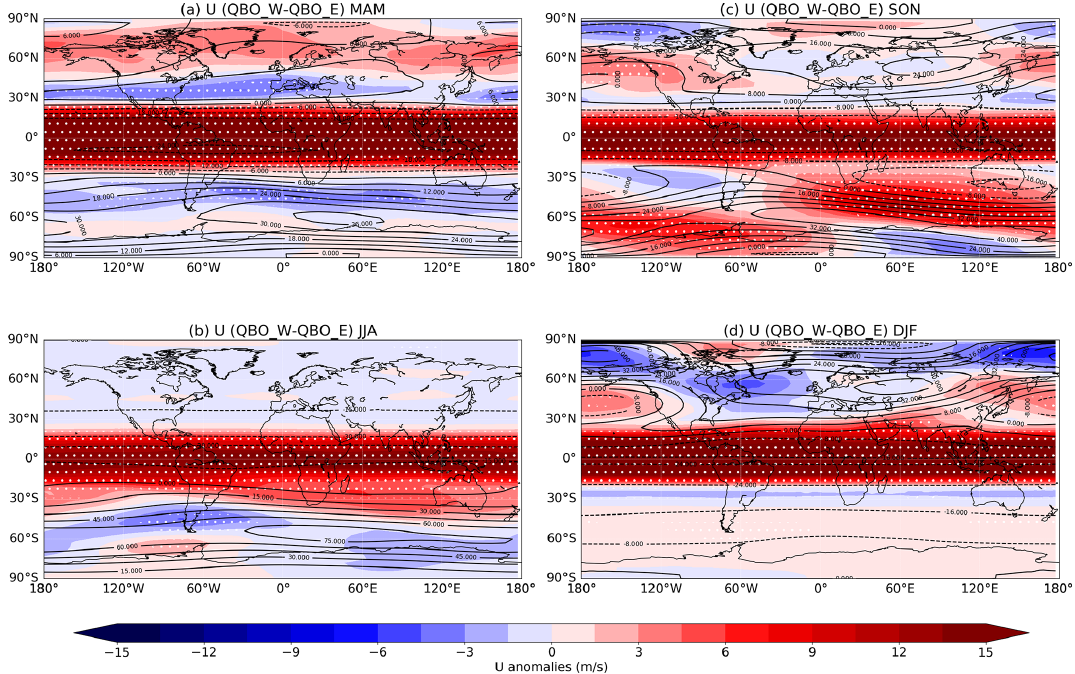
Figure 9. Influences of QBO (QBOW–QBOE) on the global zonal wind ( U at 10hPa), based on ERA5 data for the period 1979–2020. The climatological values of zonal winds during QBOE in each season are also shown (contour lines, with contour intervals of 6, 15, 8, and 8ms − 1 in panels (a) , (b) , (c) , and (d) , respectively). (a) MAM. (b) JJA. (c) SON. (d) DJF. Stippled areas indicate results that are statistically significant over the 95% level, using the two-tailed Student’s t